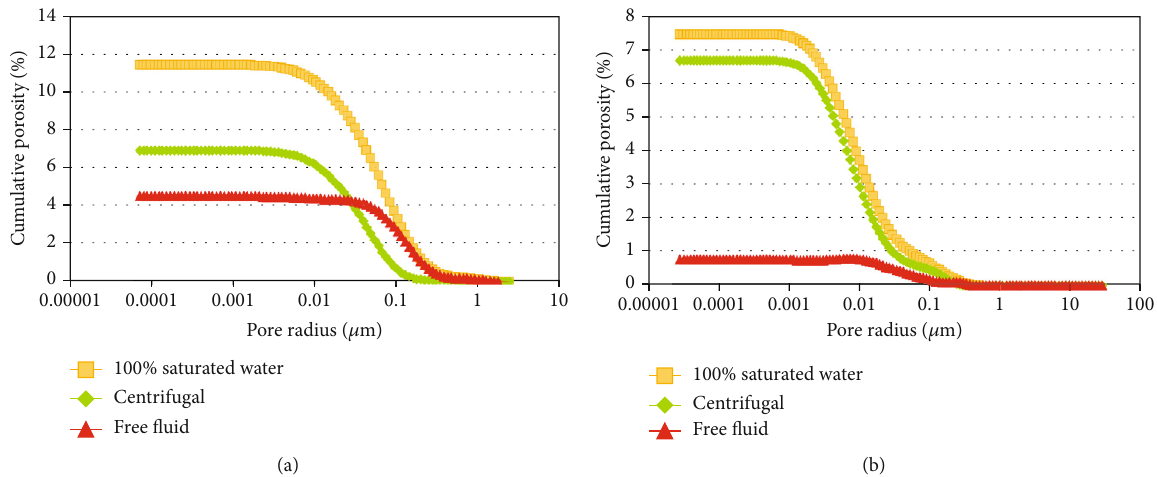
Figure 7: Calculation results of the free fl uid T 0.6